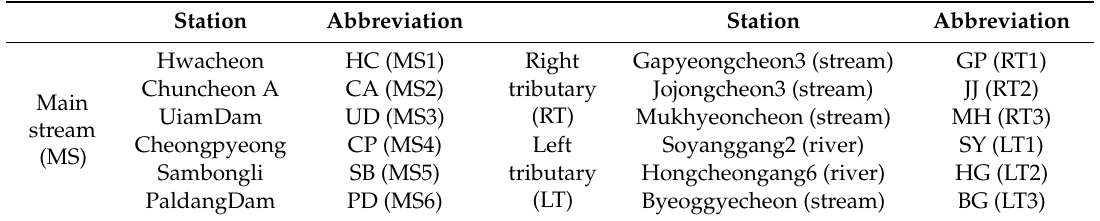
Figure 1. Bukhan River drainage system ( a ). Map-based drainage system schematic and ( b ) schematic diagram of the drainage system. Table 1. Abbreviations of water quality monitoring stations of the Bukhan